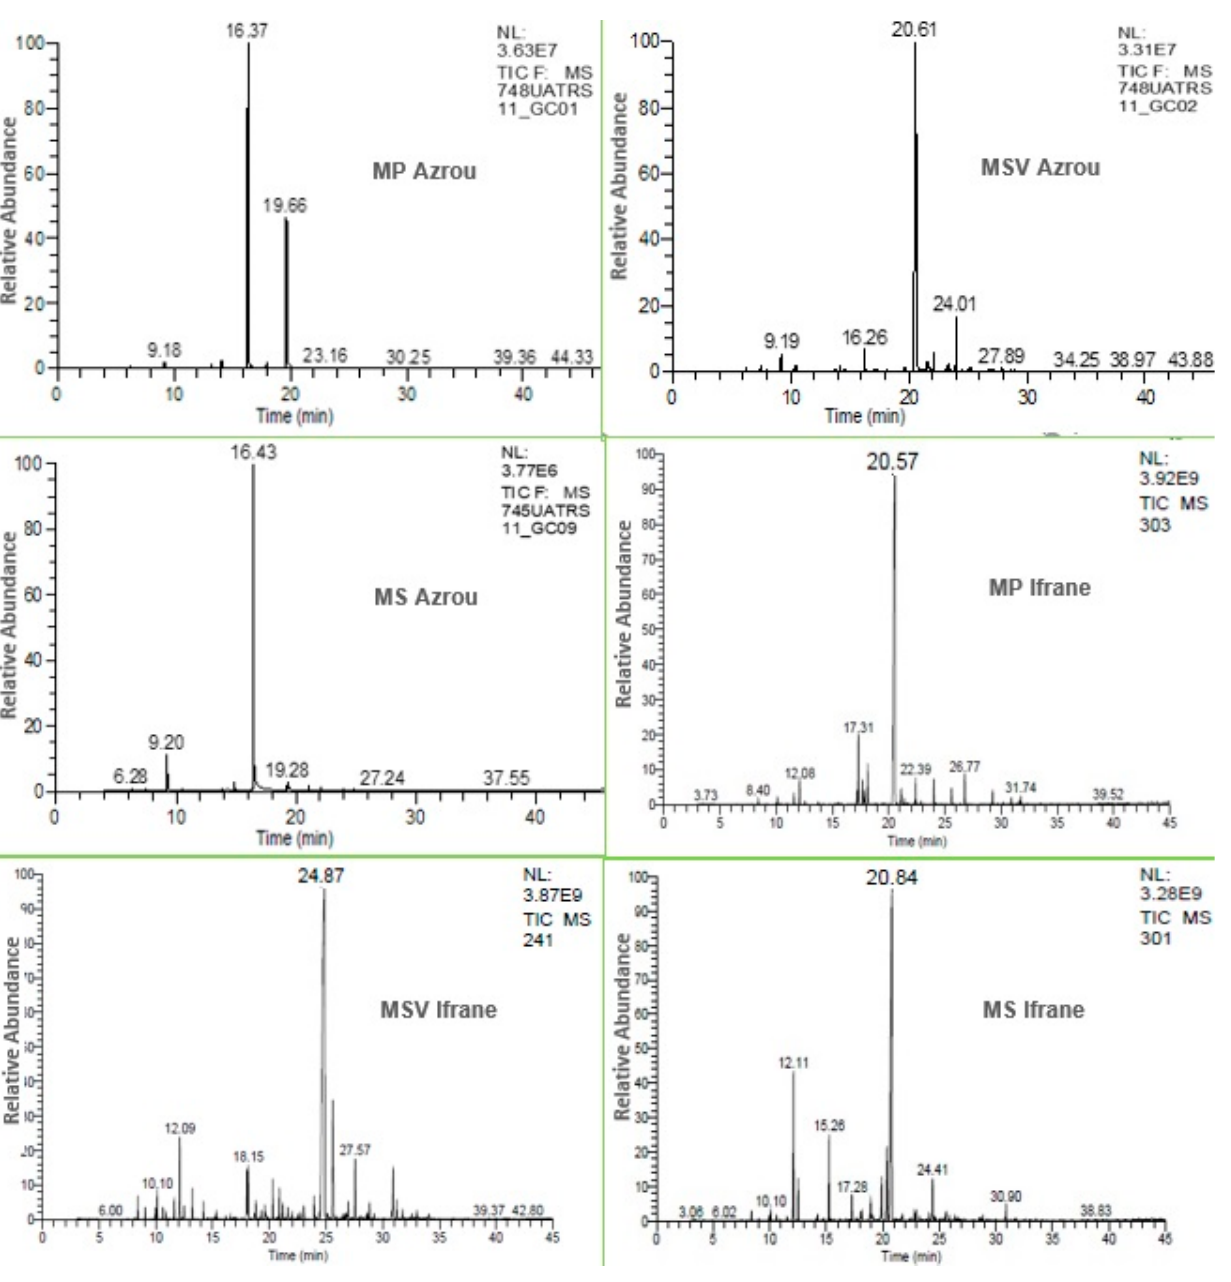
Figure 2. Chemical profiles of the studied mint EOs. MP Azrou: M. pulegium ; MP Ifrane: M. pulegium ; MSV Azrou: M. suaveolens ; MSV Ifrane: M. suaveolens ; MV Azrou: M. Spicata ; MV Ifrane: M. spicata .